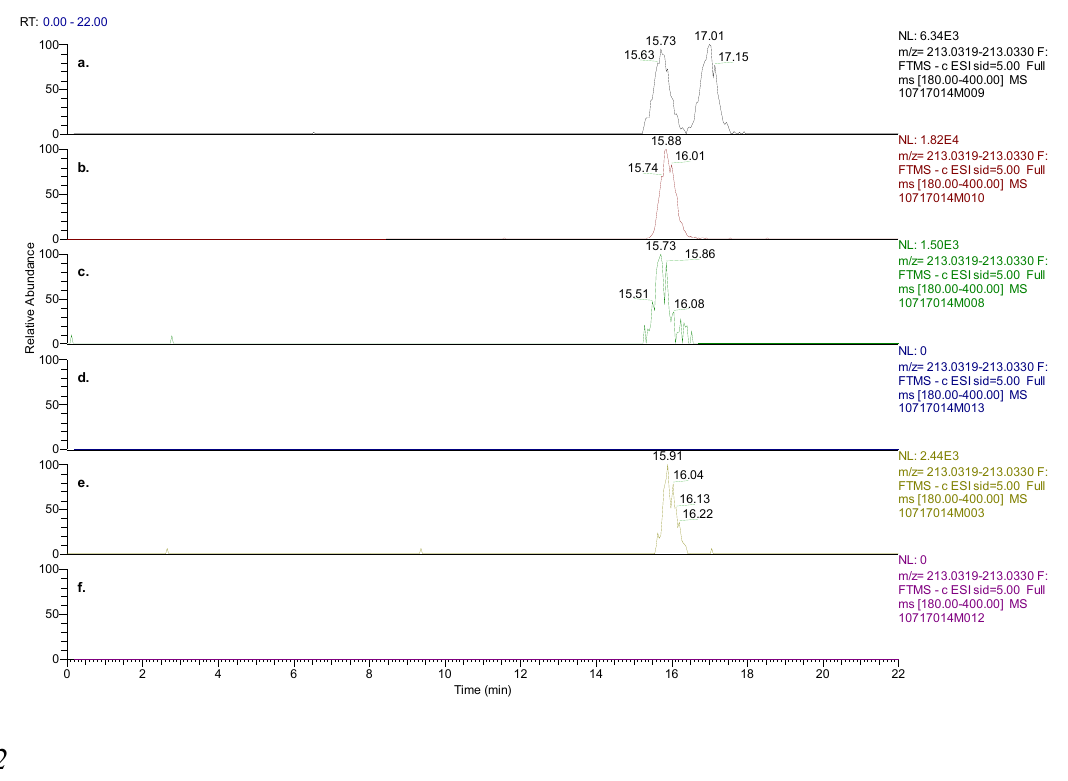
Figure 7. ( a ) Chiral chromatographic separation of M1 enantiomers present in racemic M1 standard, ( b ) S-M1 standard, ( c ) plasma 0–12 hrs pooled samples from human subjects dosed with baclofen, ( d ) plasma 0–12hrs pooled samples from human subjects dosed with STX209, ( e ) urine 0–48 hrs pooled samples from human subjects dosed with baclofen, and ( f ) urine 0–48 hrs pooled samples from human subjects dosed with STX209. The experimental results demonstrated the absence of M1 metabolite in subjects dosed with